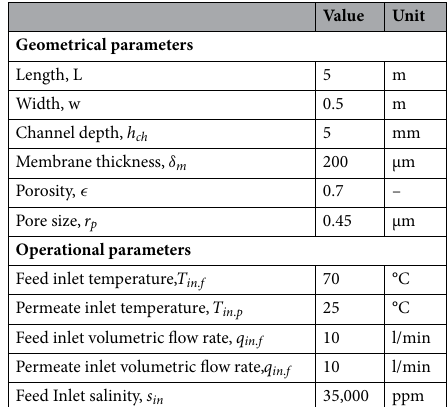
Geometrical parameters